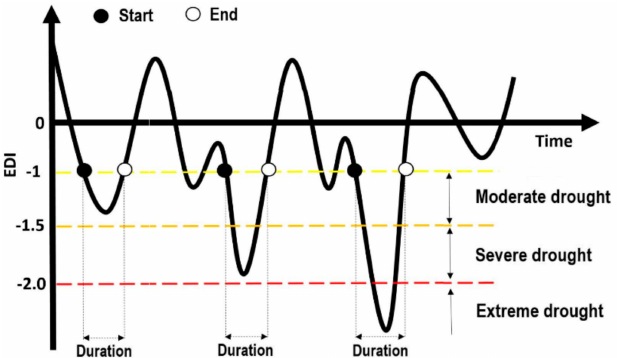
Figure 3. Schematic concept of the drought characteristics (severity, duration) evaluated with the EDI time series.